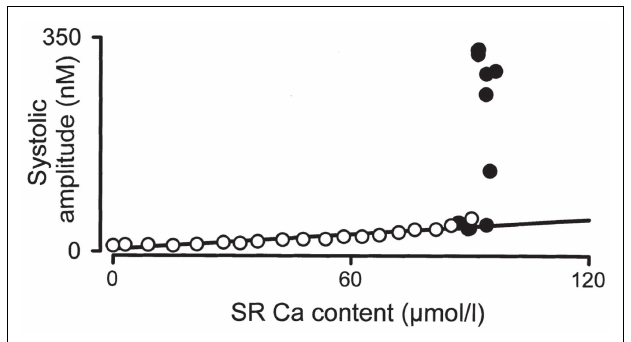
FIGURE 8 | Load dependence of SR Ca 2 + release. The relationship between the SR Ca 2 + content and the amplitude of the systolic Ca 2 + transient are shown for rat ventricular myocytes. Adapted from Díaz et al.